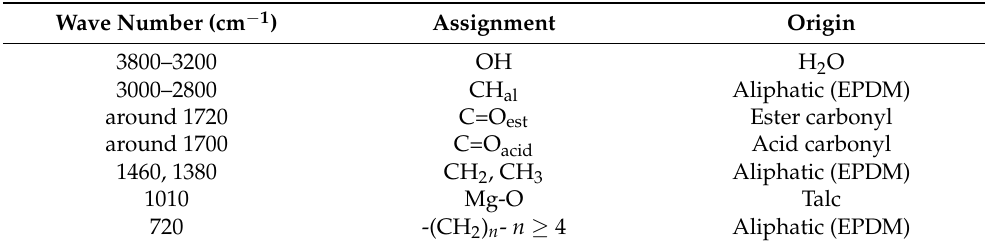
Table 3. IR absorption bands and their